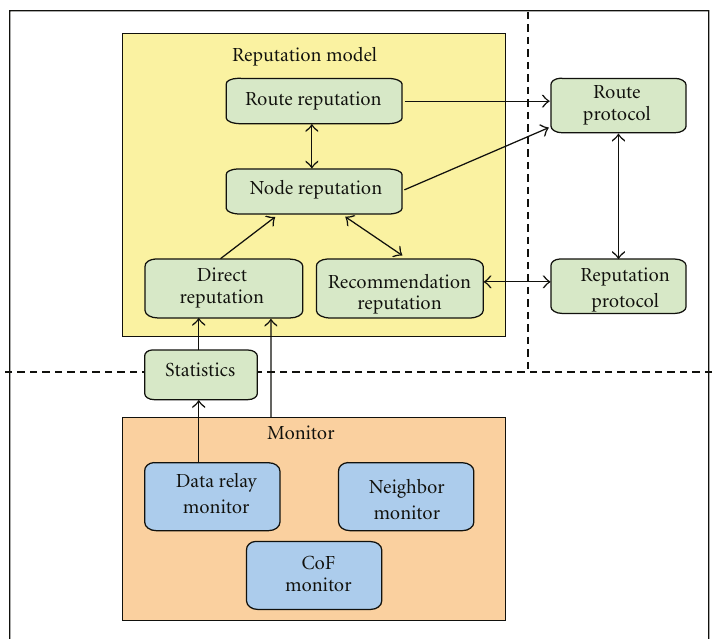
Figure 1: Architecture of COSR